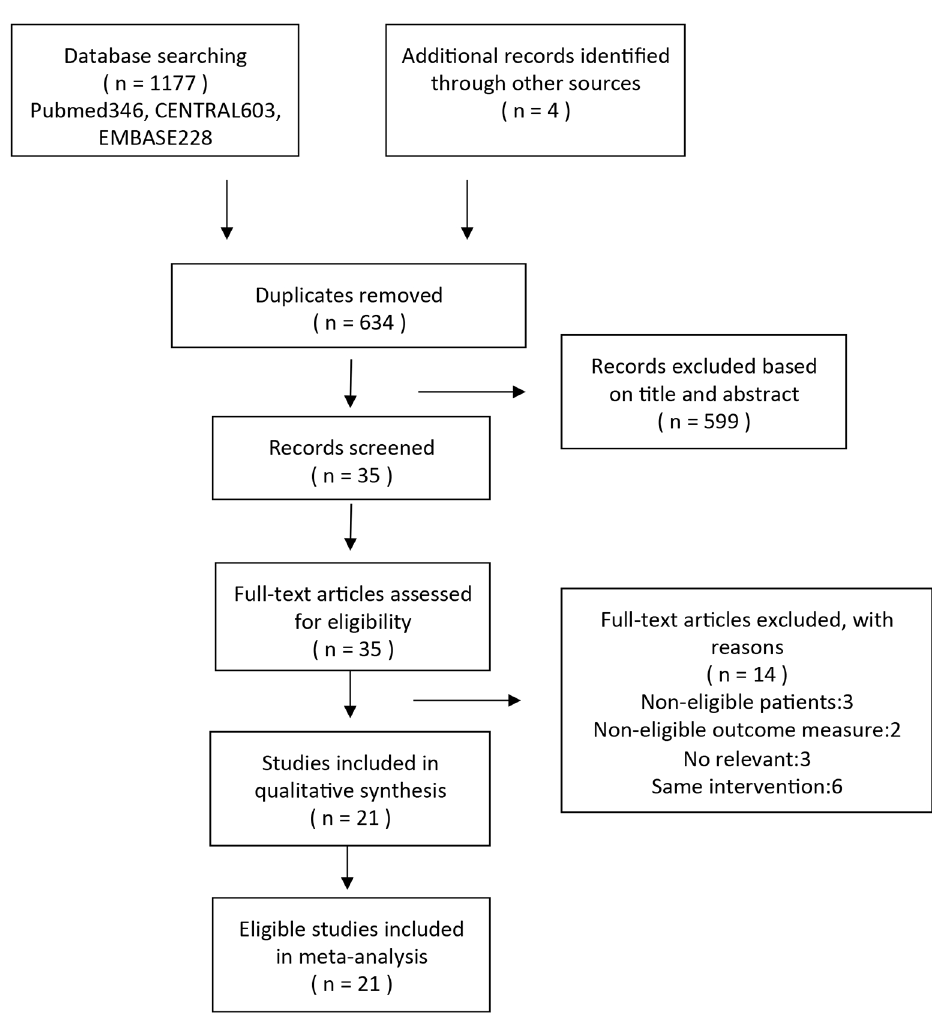
Fig 1. Flow chart indicating the selection process for this network